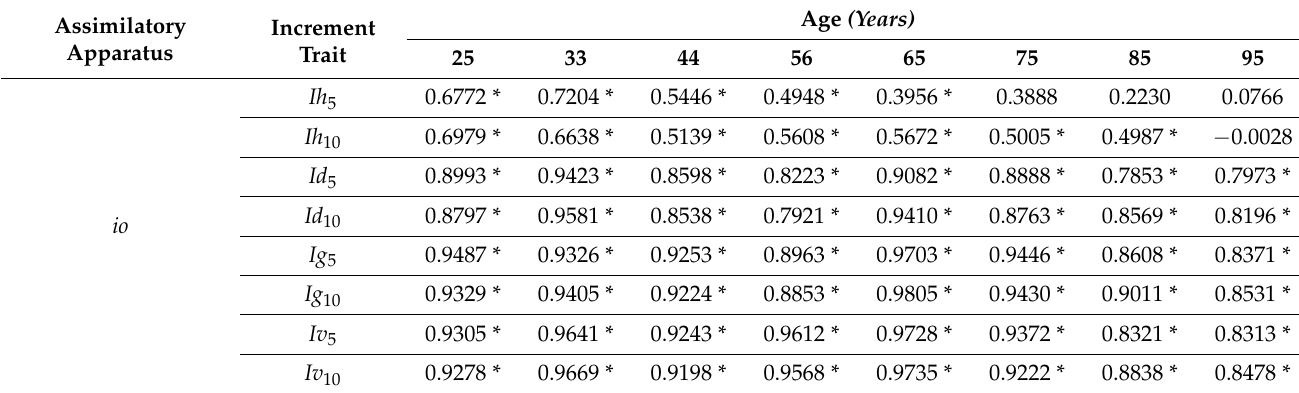
Table 10. Values of linear correlation coefficients r between needle volume ( io ) and increment traits ( Ih 5 , Ih 10 , Id 5 , Id 10 , Ig 5 , Ig 10 , Iv 5 , Iv 10 ) depending on the age of the stands.